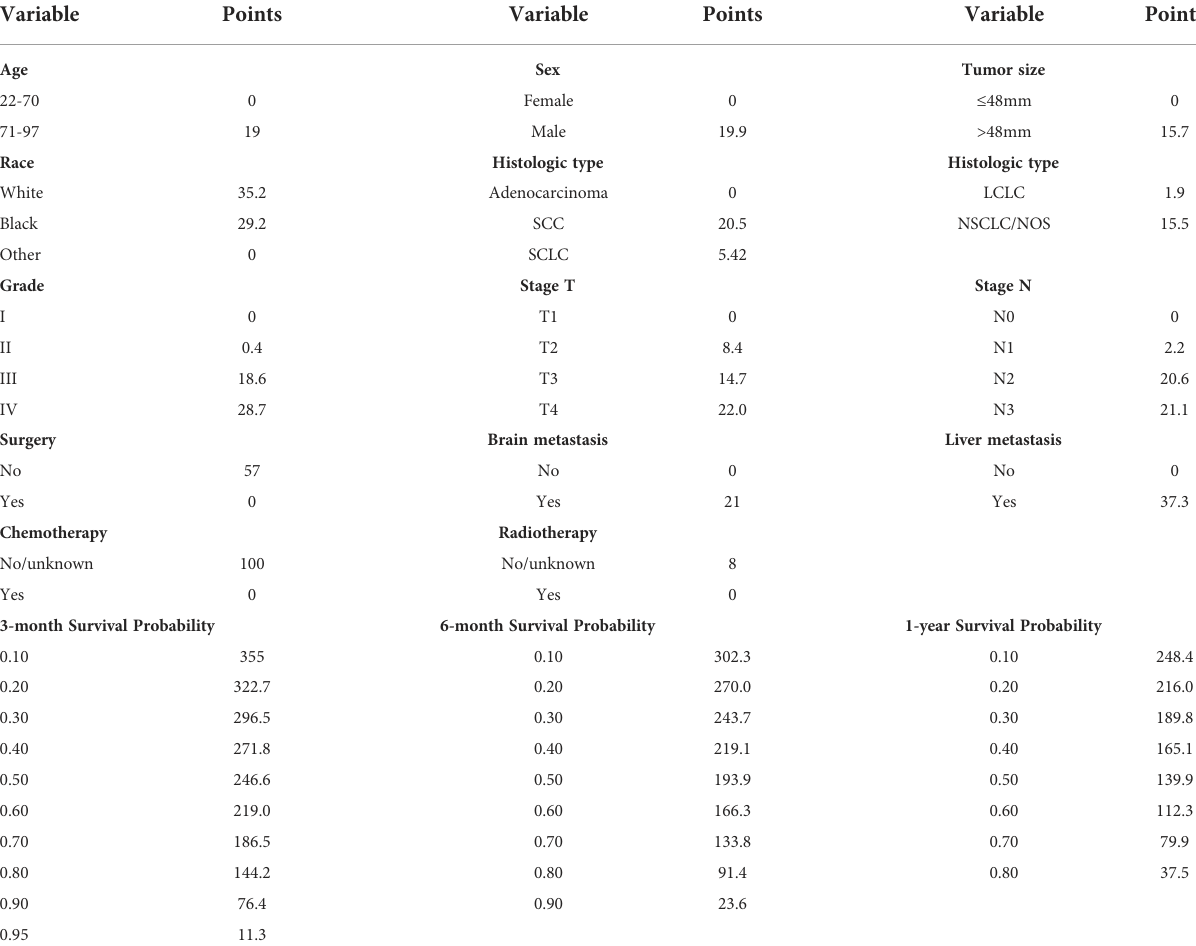
TABLE 3 Nomogram scoring system.